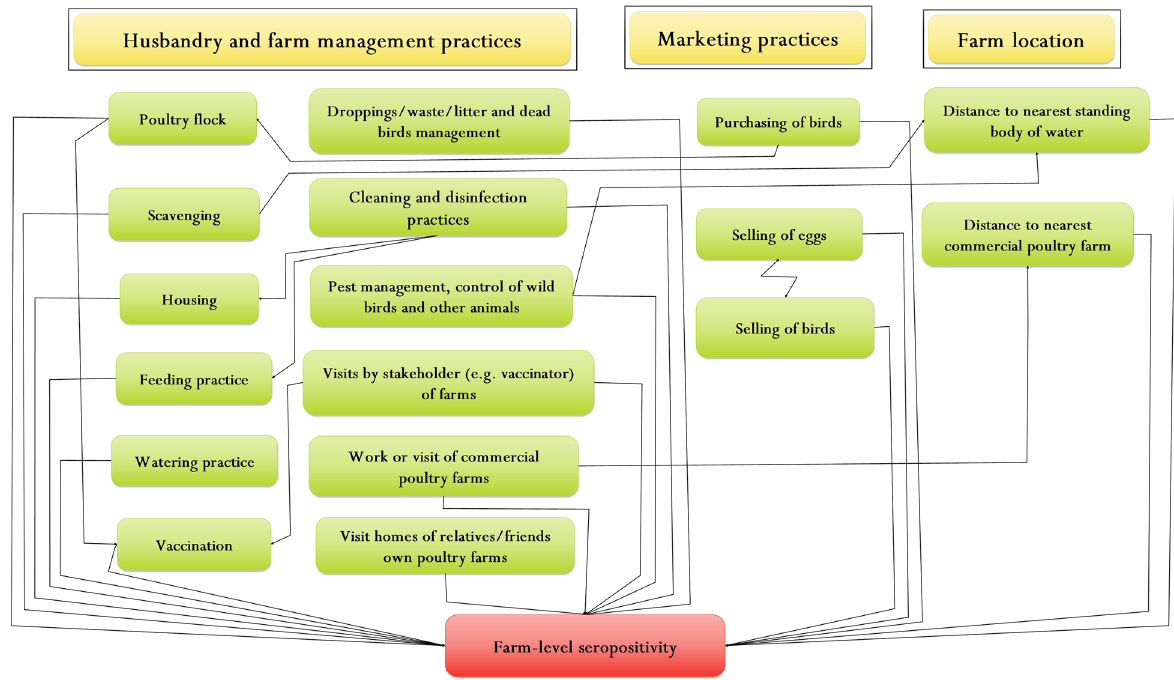
Figure 1. Hypothesized causal pathways for farm-level risk factors (green boxes) associated with avian influenza farm-level seropositivity (red box) in backyard chickens in Bangladesh. Yellow headings represent themes or categories under which risk factors can be combined. The causal pathways were used to inform the development of questions used in the interviews with backyard farmers and guided the inclusion of potential confounders and interactions in the final multi-variable